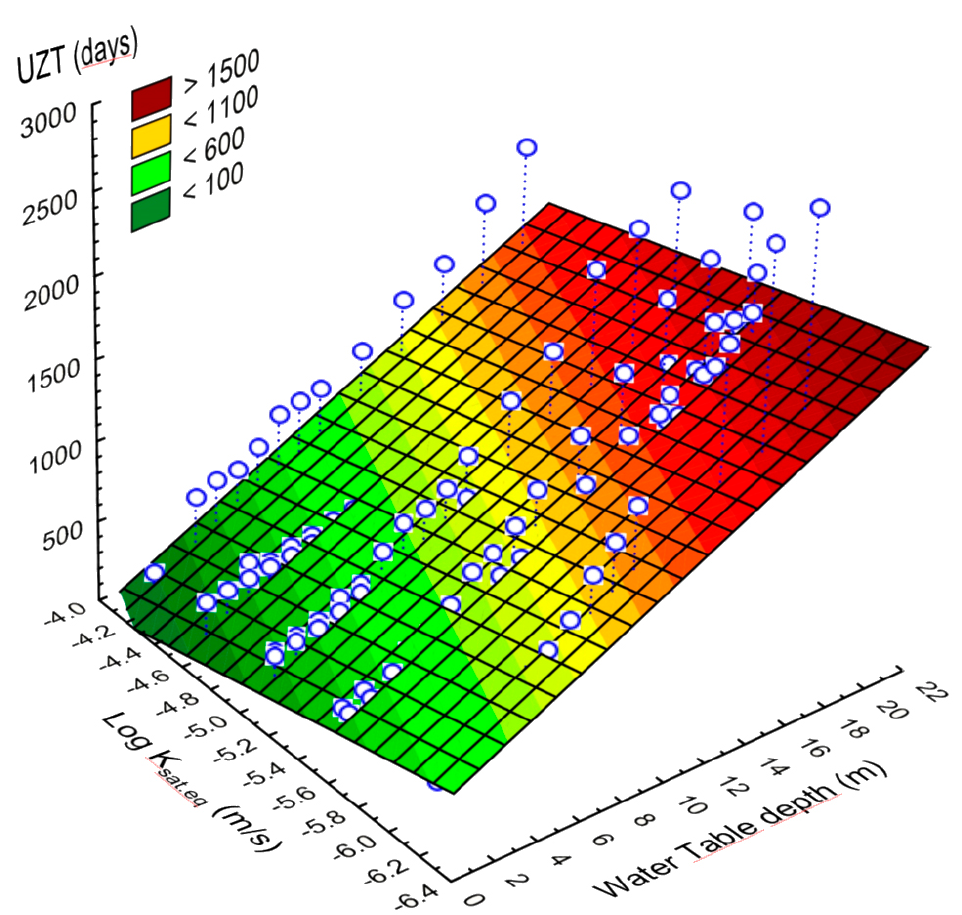
Figure 8. Bivariate empirical correlation between UZT, water table depth (D), and the equivalent hydraulic conductivity of the unsaturated zone values (K sat.eq ) reconstructed by the results of homogenous and heterogeneous hydro-stratigraphic models.